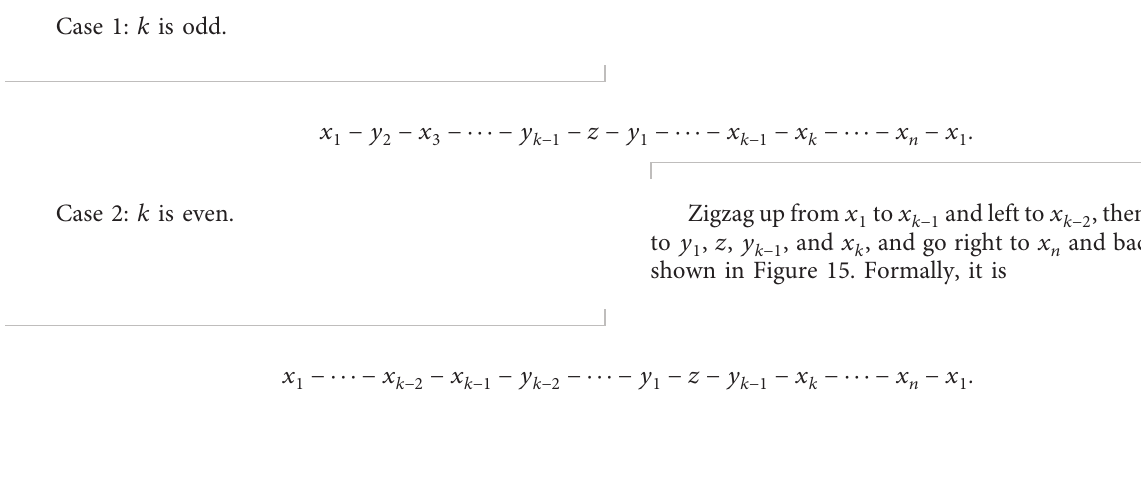
Figure 9: F obtained from F 14